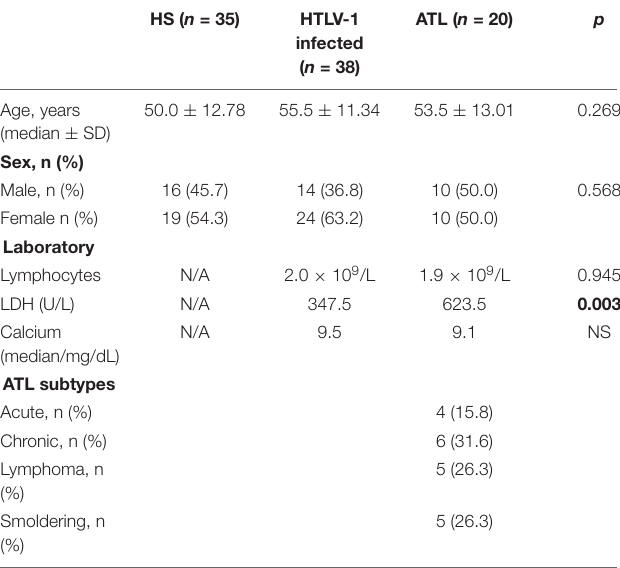
TABLE 1 | Clinical findings of